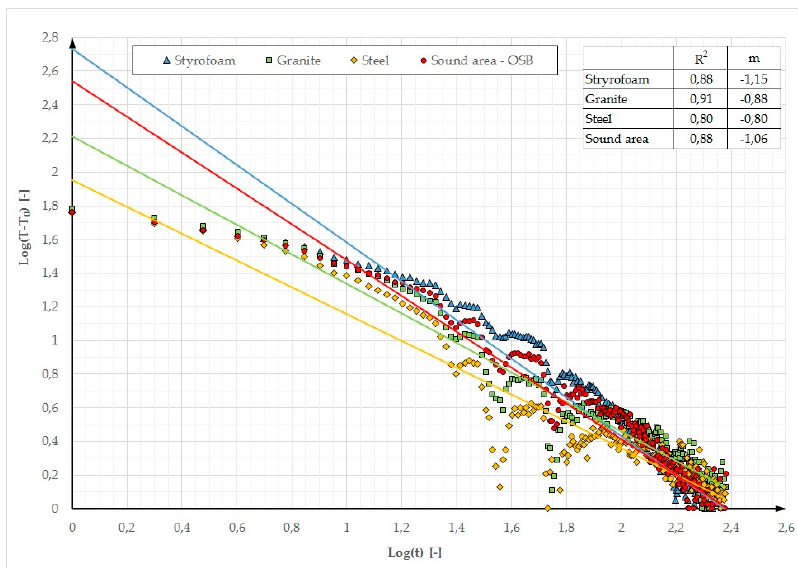
Figure 17. Log–log graph of the cooling phase and R 2 and m values (stimulated period 30 min) for the GB partition model with heating from a distance of 0.5 m.